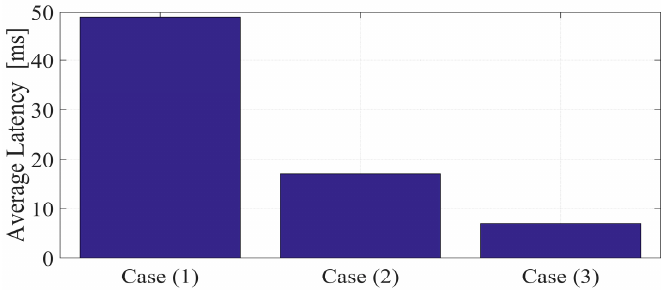
Figure 10. The average end-to-end latency for the considered simulation cases.